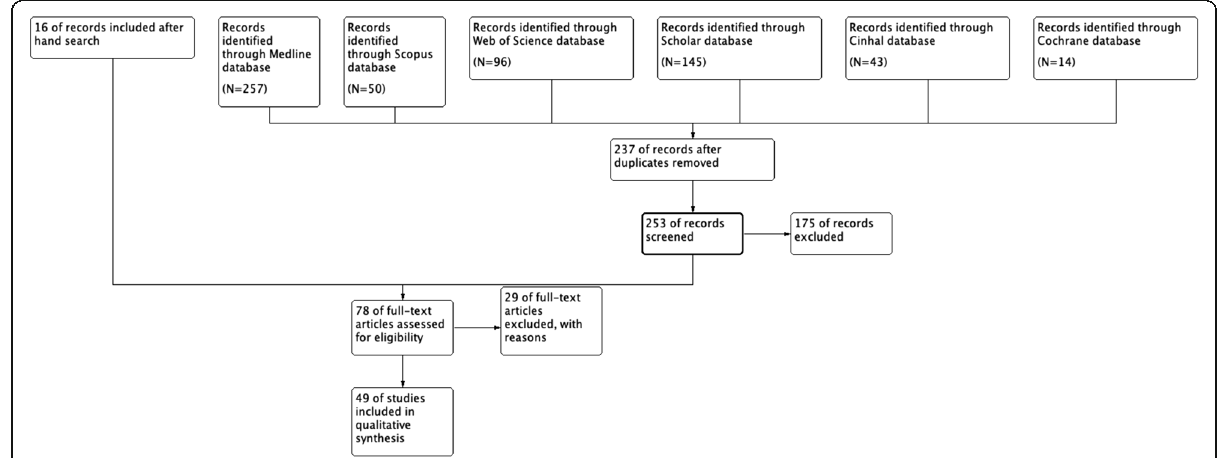
Fig. 2 PRISMA flowchart summarizing the literature search